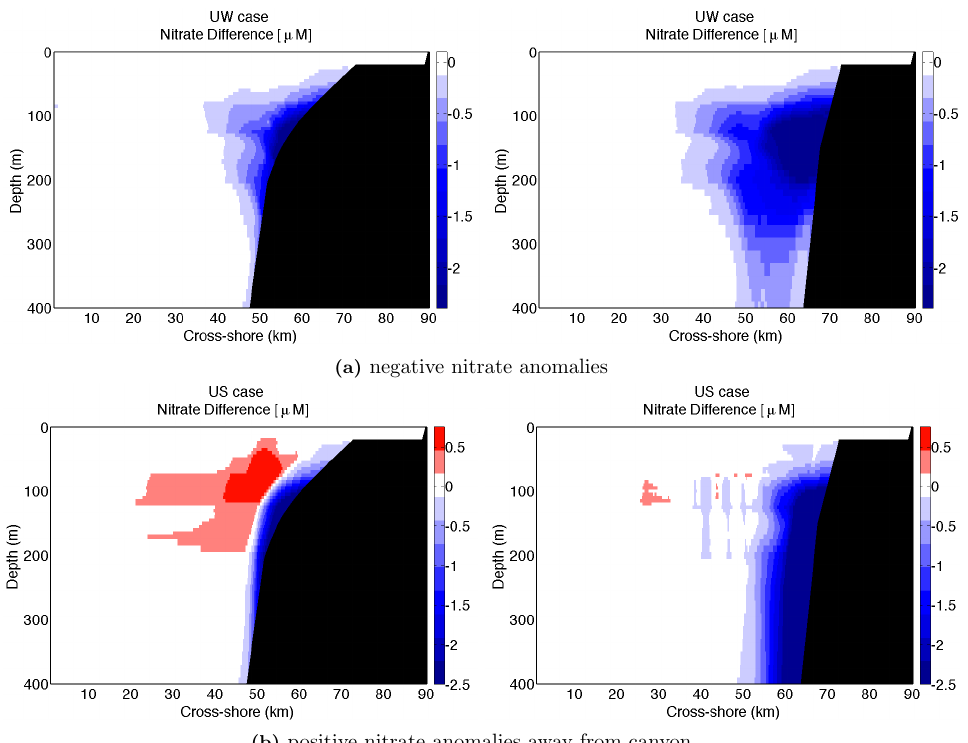
Figure 10. Nitrate anomaly 10km upstream of canyon axis (left) and along canyon axis (right) in (a) a simulation with pattern 1, i.e. negative nitrate anomalies at all depths (UW), and (b) a simulation with pattern 2, i.e. positive nitrate anomalies away from the canyon (US). Pattern 1, negative nitrate anomalies at all depths, corresponds to pattern 1, negative density anomalies at all depth (Fig. 9a); similarly, pattern 2, positive nitrate anomalies away from the canyon, corresponds to pattern 2, positive density anomalies away from the canyon (Fig. 9b). Anomalies are averaged over a period of 3 model days during the advection phase (model days